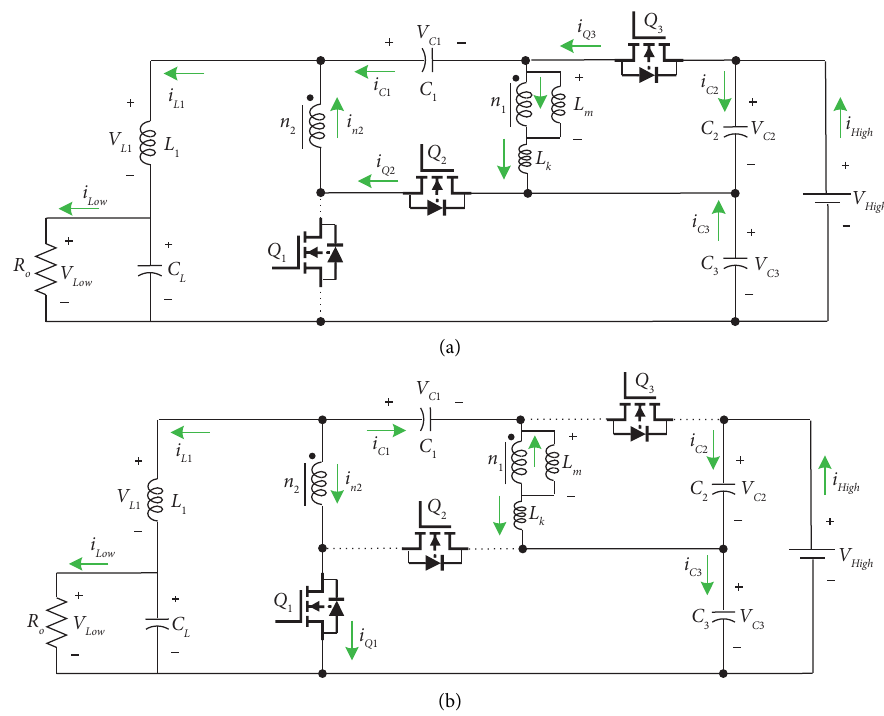
Figure 4: Te equivalent circuits in step-down mode: (a) state 1 and (b) state